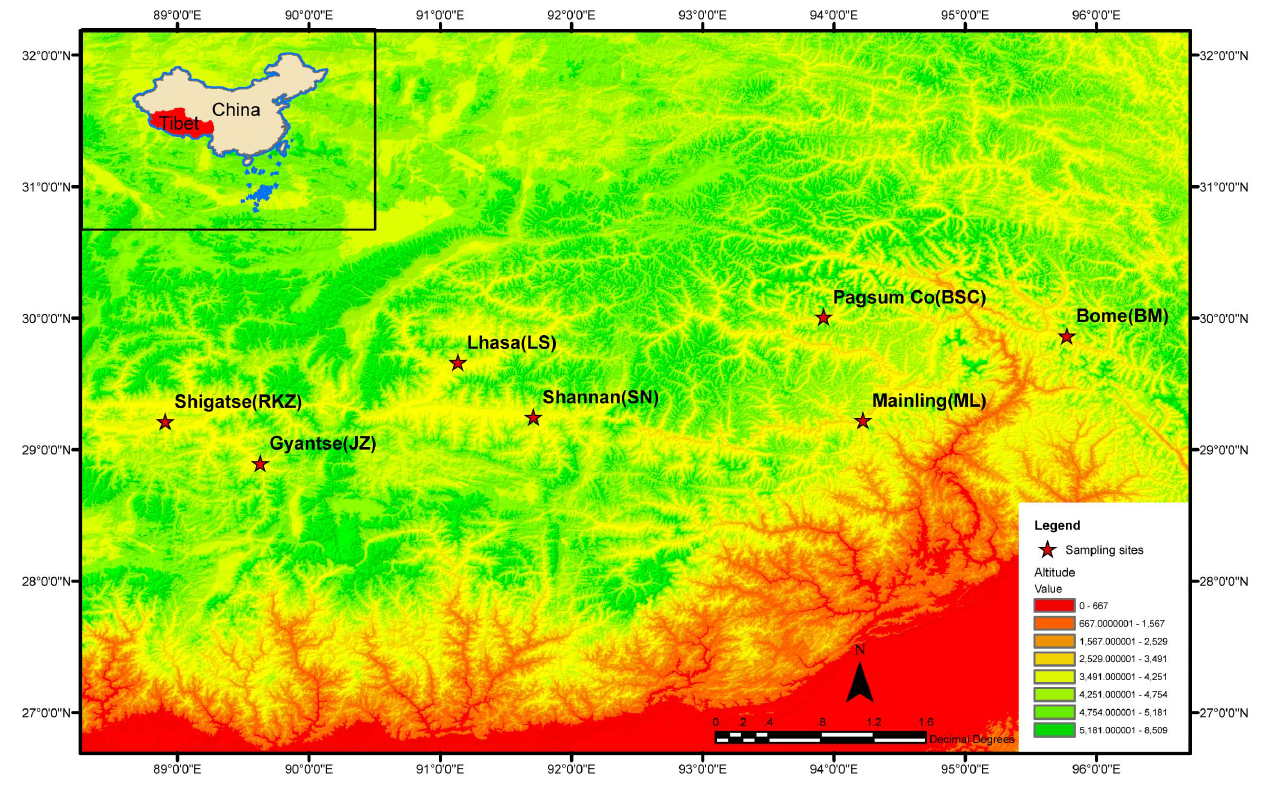
Figure 5. Sampling sites in the Qinghai-Tibetan Plateau in China. Samples were collected from seven locations from West to East in Tibet, representing different ecological conditions. RKZ - Shigatse, Gyantse - JZ, Lhasa - LS, Shannan - SN, Pagsum Co - BSC, Mainling - ML, and Bome - BM.